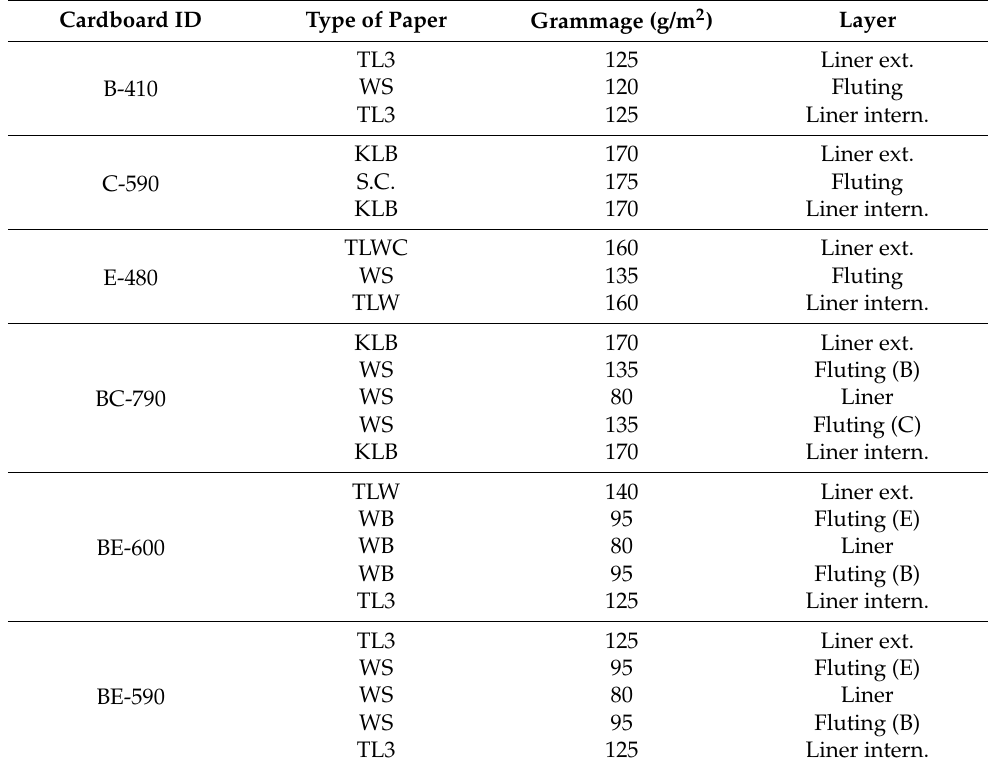
Table 3. Designation of the constituent papers of the tested corrugated